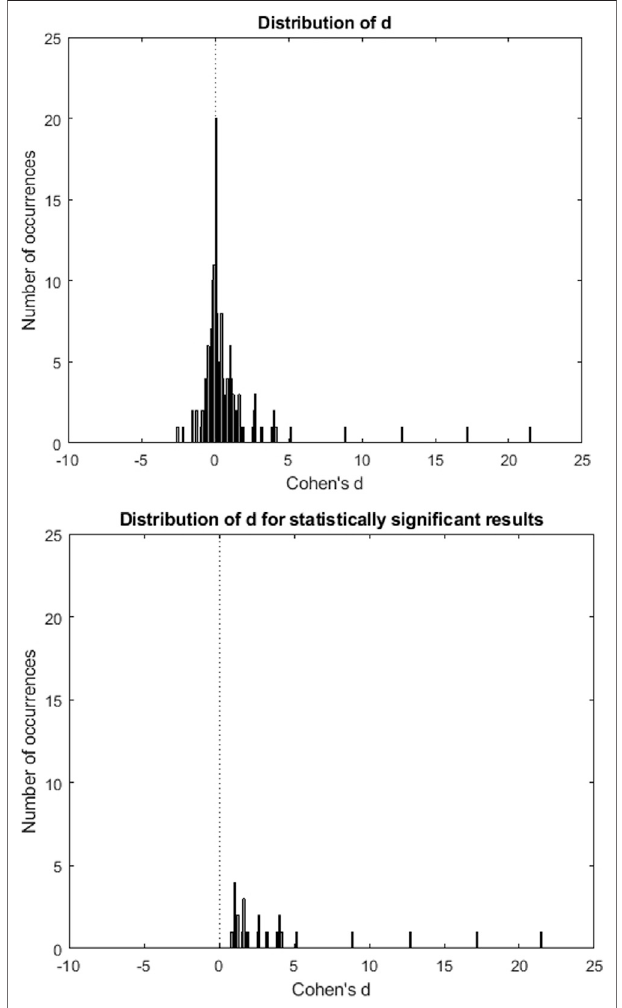
FIGURE 4 | (A) Distribution of effect sizes (Cohen ’ s d) across 157 experiments reported in 31 studies, including both statistically signi fi cant and not signi fi cant changes. One outlier with d (cid:1) 63.7 (Kesari and Behari, 2009) is off scale in the fi gure. (B) Distribution of effect sizes (Cohen ’ s d) across 30 experiments reported in 31 studies. All of these experiments reported statistically signi fi cant effects of exposure. One outlier with d (cid:1) 63.7 (Kesari and Behari, 2009) is off scale in the fi gure. The increases in d compared to (A) arises in part from the exaggeration in effect size due to NHST; the possibility of experimental errors cannot be